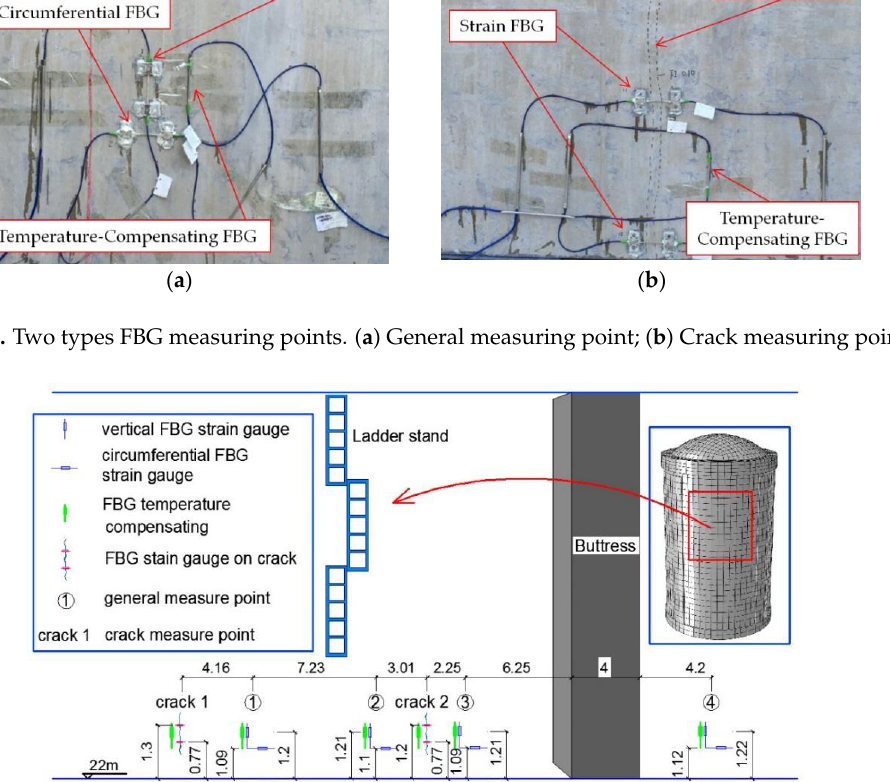
Figure 3. The measuring point locations on the PCCV and the specific location of each measure point (length unit: